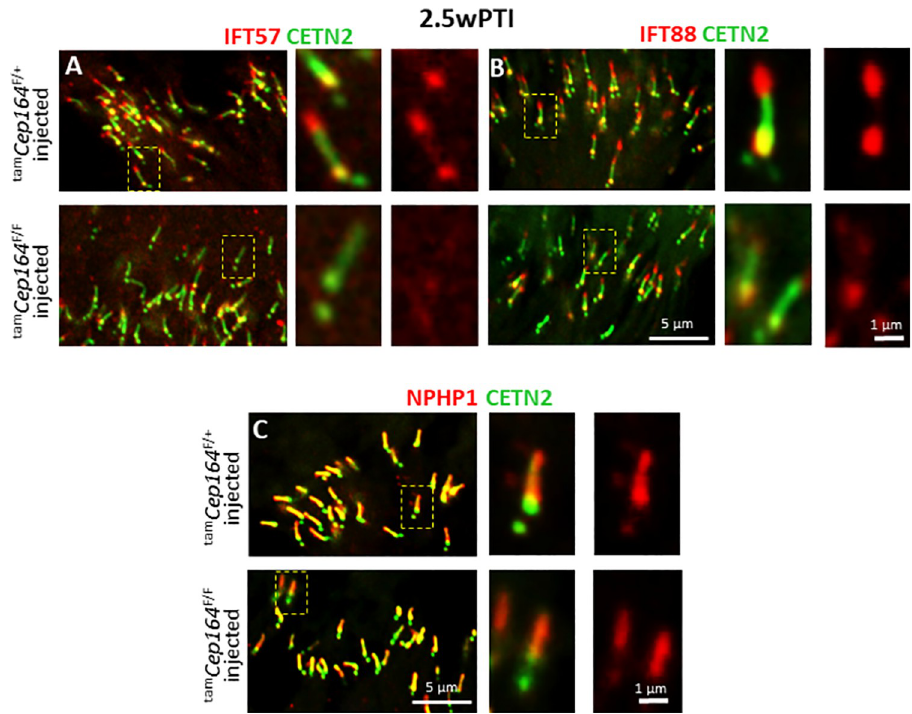
Fig 10. Immunohistochemistry with anti-IFT57, anti-IFT88 and anti-NPHP1 in tam Cep164 -/- mice. A-C, immunohistochemistry of 2.5wPTI tam Cep164 +/- (upper panels) and tam Cep164 -/- (lower panels) photoreceptors probed with anti-IFT57 (red) (A), anti-IFT88 (B) and anti-NPHP1 (C) antibodies. Fluorescent signals of IFT57 and IFT88 immunolabeling are reduced in the knockout, NPHP1 is stably bound to the CC. Insets (right) show enlargements of representative BB/CC structure identified by Egfp-CETN2 (green) or individual antibodies (red).